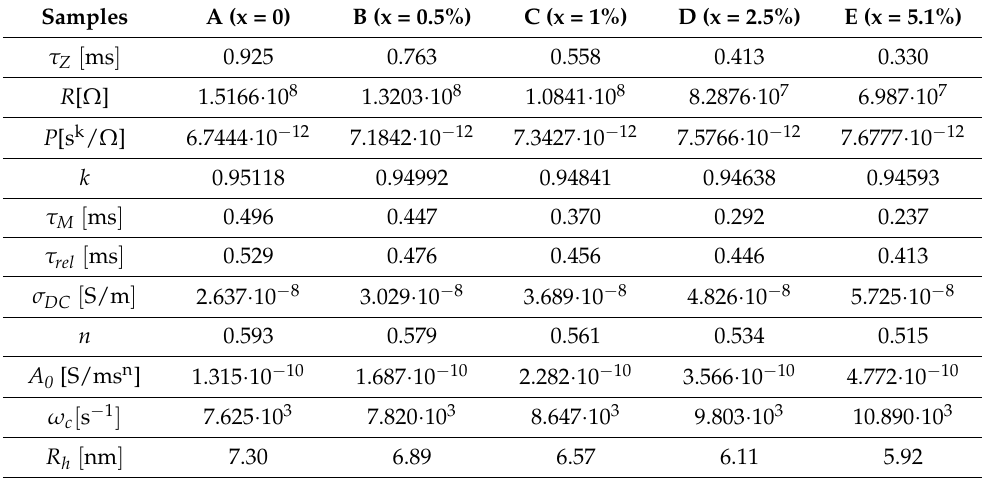
Table 1. Electrical parameters of composite samples, determined from